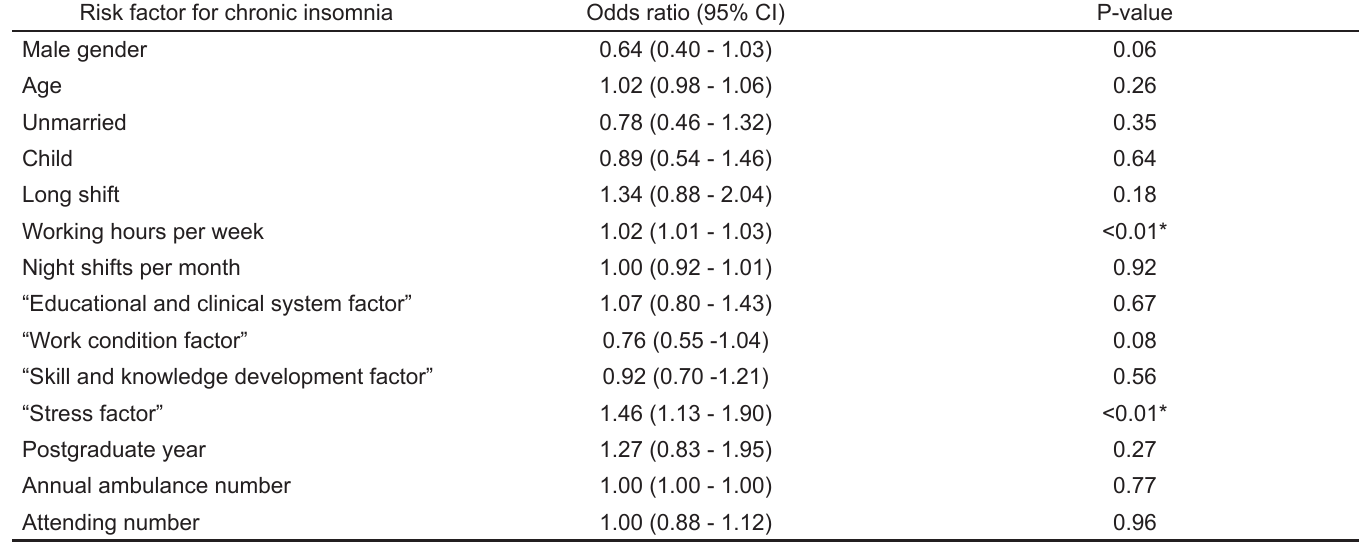
Table 4. Multivariable logistic regression analysis for chronic insomnia.